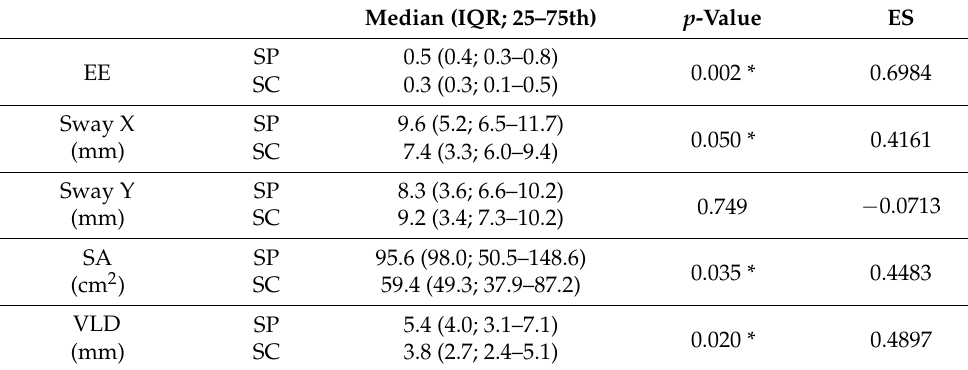
Table 2. Sway and Spine 3D outcomes in the two different